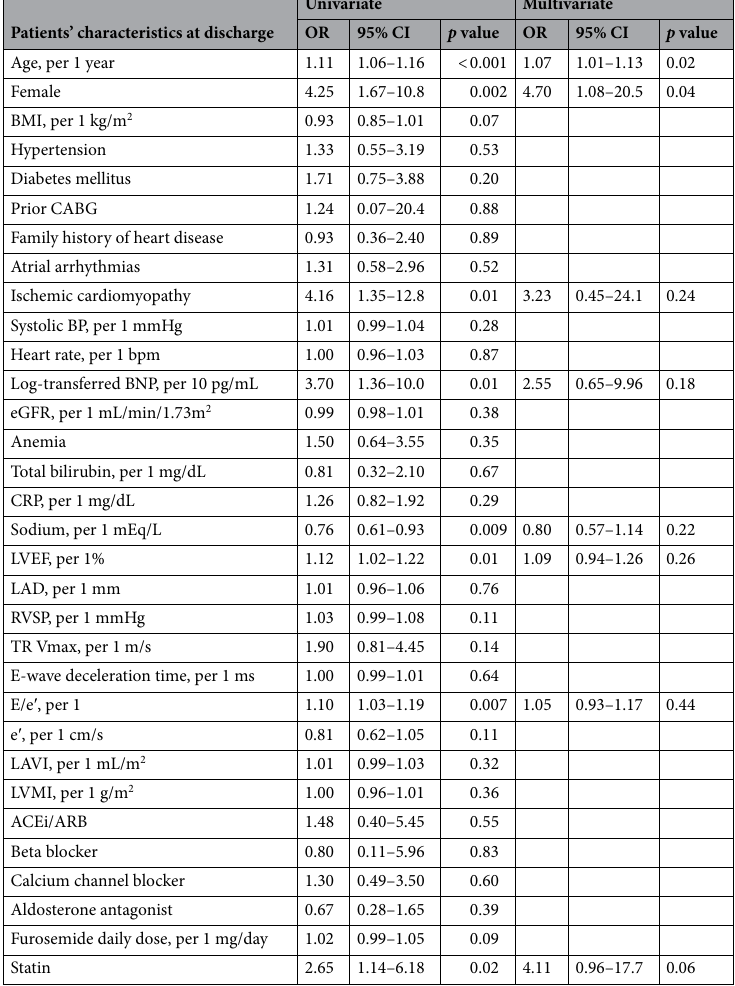
Table 4. Predictors of HFrecEF with high E/e ′ ratio at the 1-year follow-up using the comorbidities and patients’ characteristics at discharge. ACEi angiotensin converting enzyme inhibitor, ARB angiotensin receptor blocker, BMI body mass index, BNP brain natriuretic peptide, BP blood pressure, bpm beats per minute, CABG coronary artery bypass grafting, CI confidence interval, CRP C-reactive protein, E/e ′ peak velocity of the early wave (E) to early diastole (e ′ ) ratio, eGFR estimated glomerular filtration rate, LAD left atrial dimension, LAVI left atrial volume index, LVEF left ventricular ejection fraction, LVMI left ventricular mass index, OR odds ratio, RVSP right ventricular systolic pressure, TR Vmax maximal tricuspid regurgitation